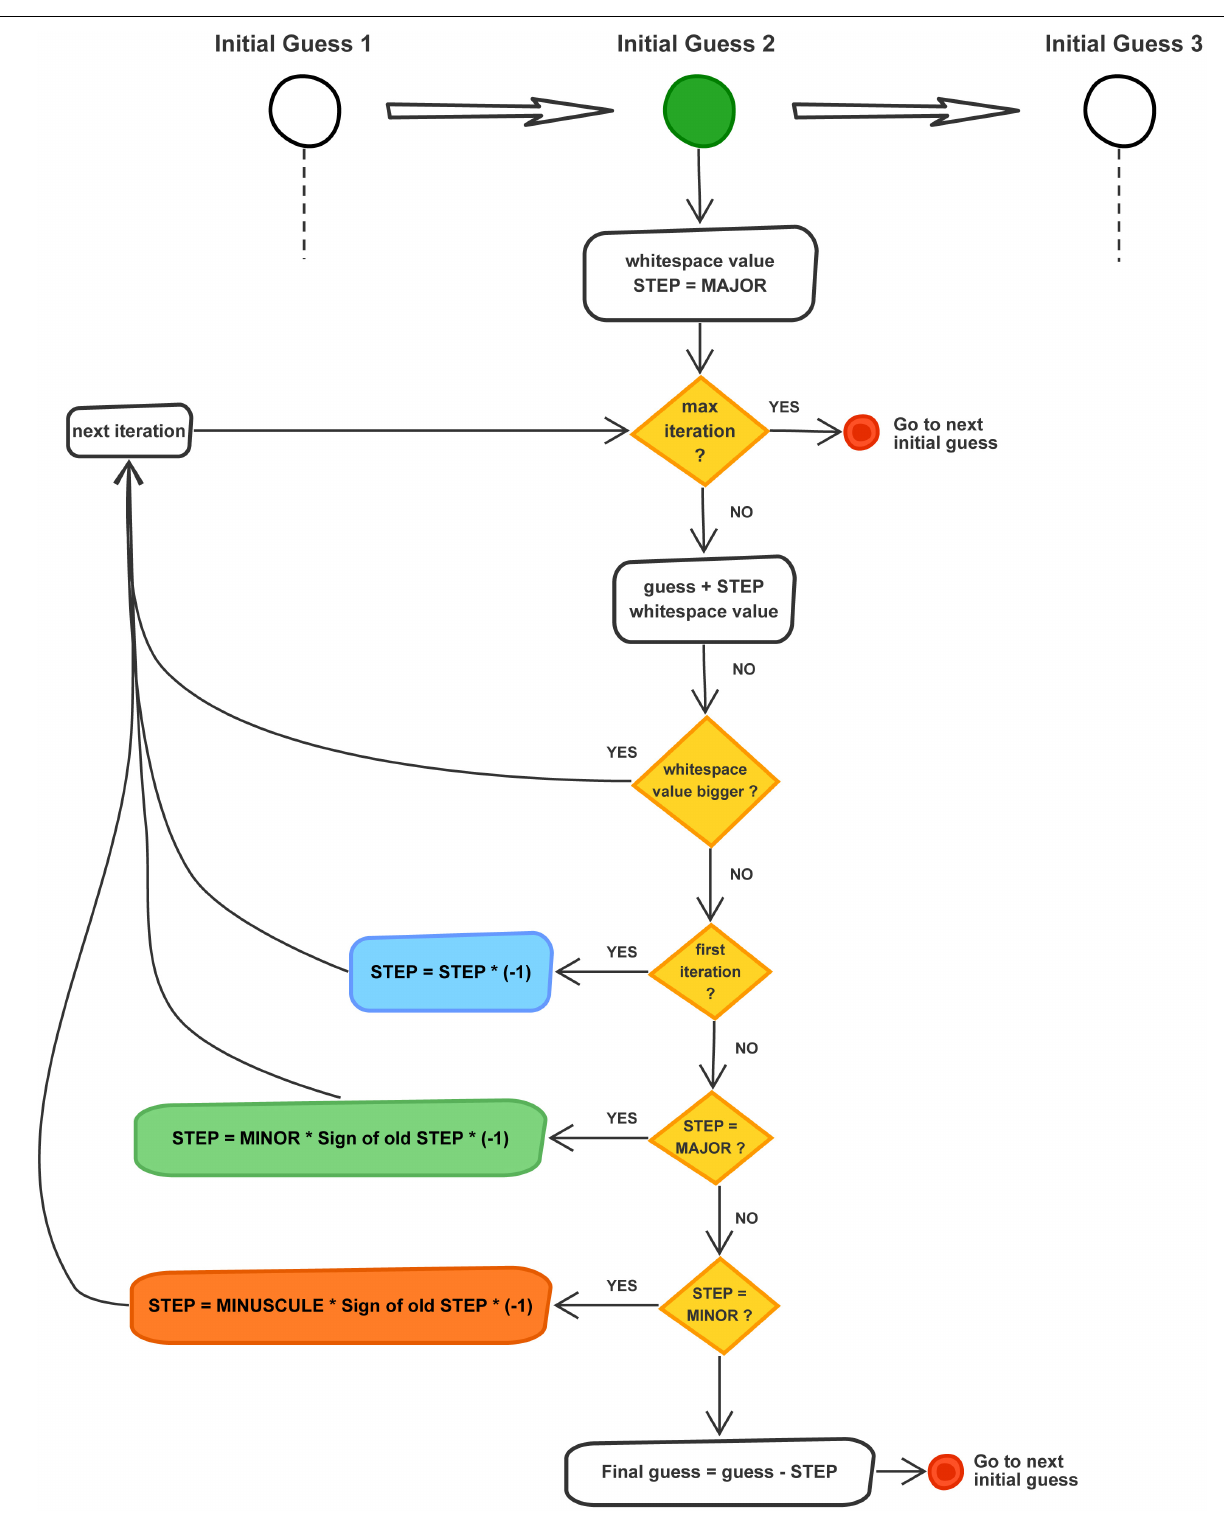
Frontiers in Marine Science |